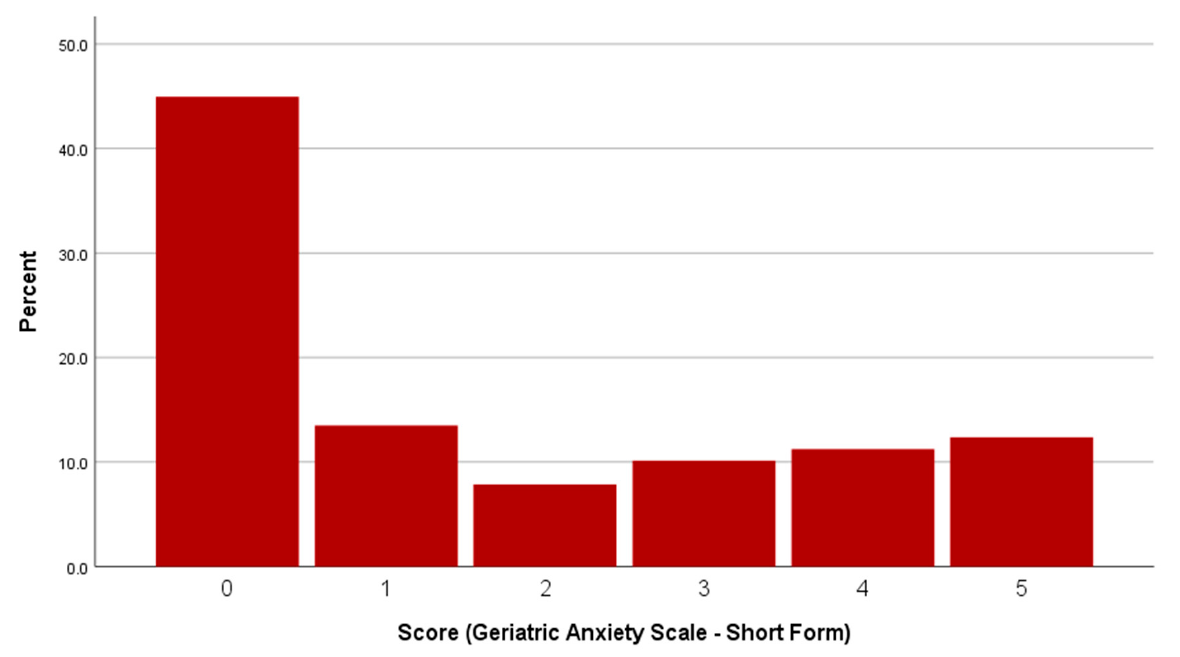
Figure 2. Distribution of nuclear test veteran scores on the Geriatric Anxiety Scale (Short-Form) ( n = 89 ).